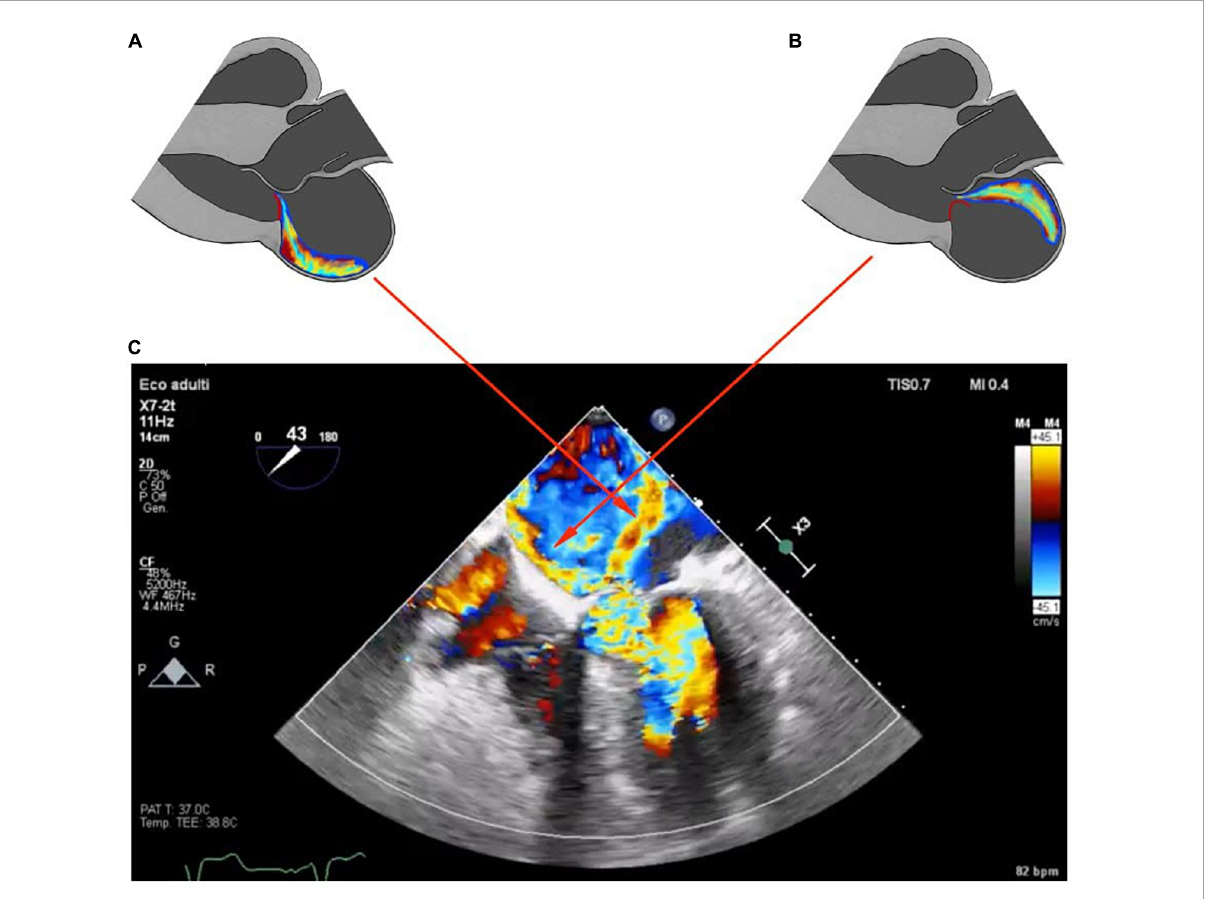
FIGURE4 Schematic representation of parasternal long axis view showing two different types of mitral regurgitation jets, SAM-related and flail-related. Panel (A) shows the posteriorly directed jet in SAM-related MR. Panel (B) shows the anteriorly directed jet of MR in PML-flail. In red the different motions of PML related to the two different jets. Panel (C) shows the two different color jets found in the reported case; red arrows correlate the two color jets with the respective schematic